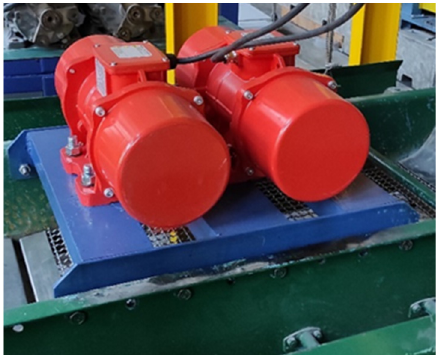
Figure 5. View of the support plate with MVE 510/1 vibrating motors mounted on the riddle of a WP screen.